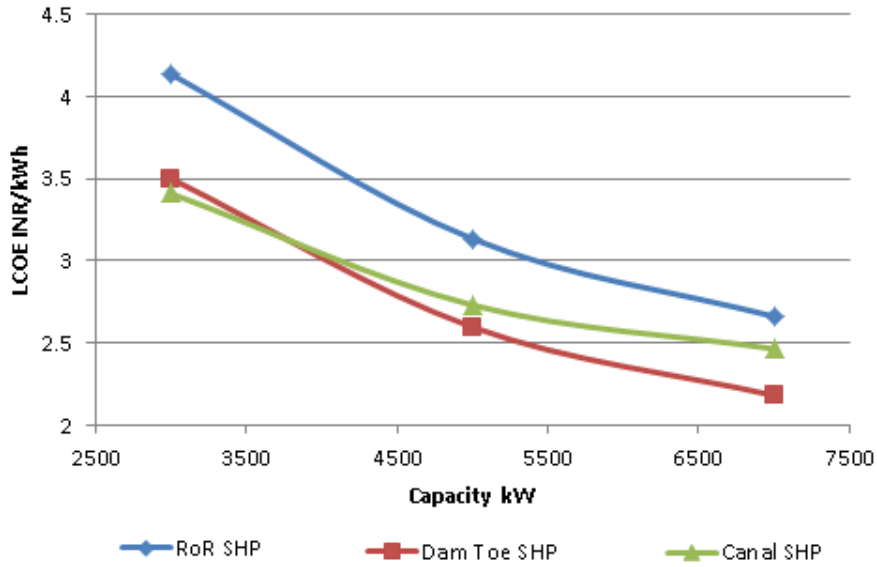
Figure 6. Variation of LCOE w.r.t capacity for low head SHP schemes.